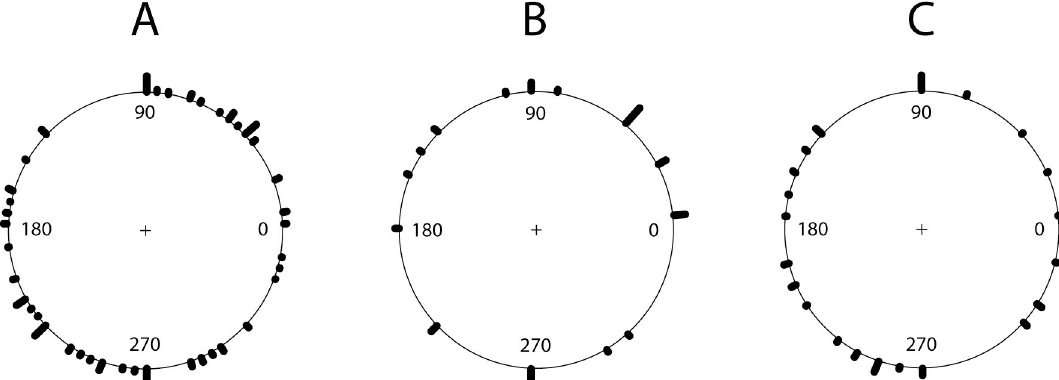
Fig 2. Overall directions flown by a) bumble bee, b) leafcutting bee and c) honey